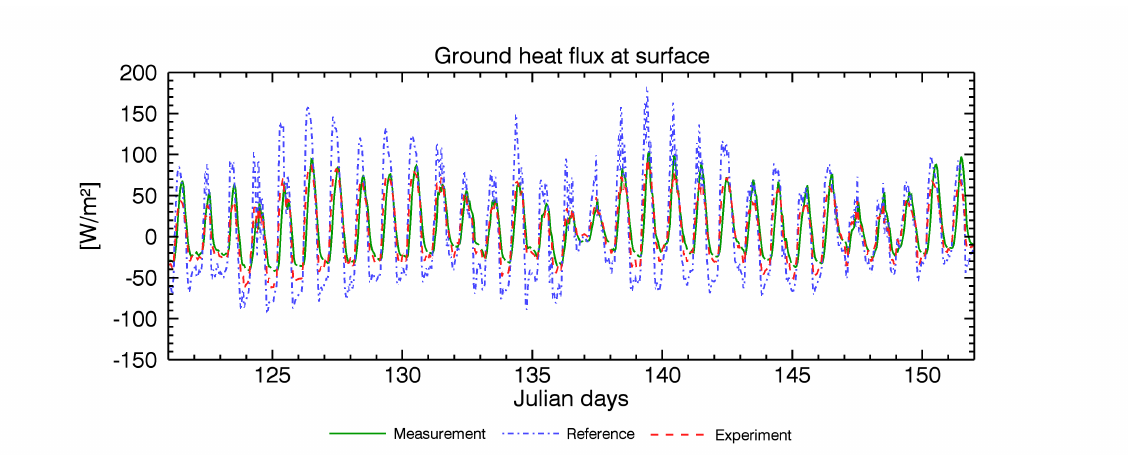
Figure 9. Same as Figure 8 but for the surface ground heat flux.